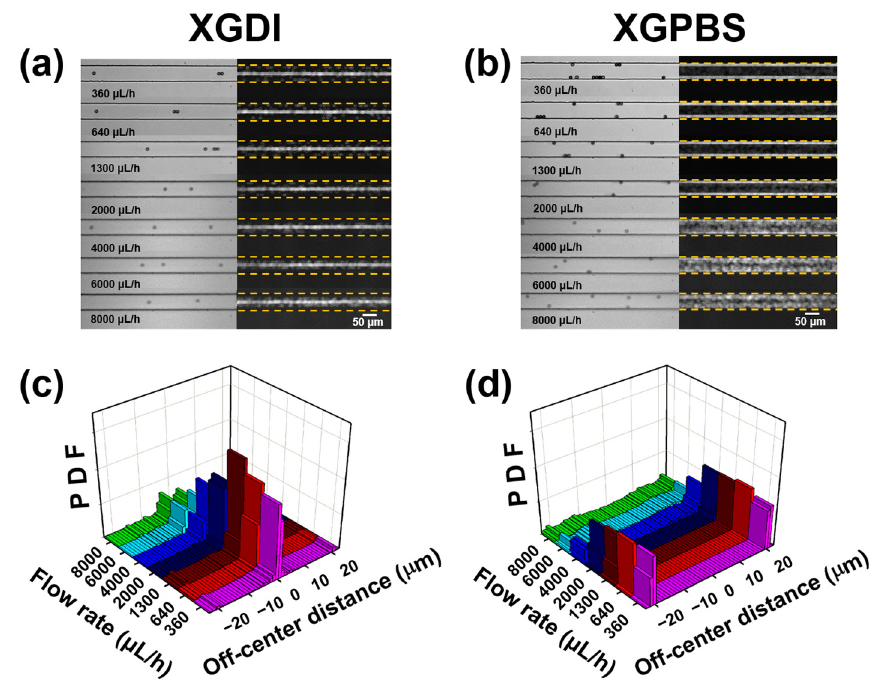
Figure 4. ( a ) Particle distributions in xanthan gum (XG) solution in deionized water (XGDI): snapshot images (left column) and standard deviation images (right column). ( b ) Particle distributions in XG solution in phosphate bu ff ered saline (PBS) solution (XGPBS): snapshot images (left column) and standard deviation images (right column). ( c ) Particle distribution function (PDF) in XGDI. ( d ) PDF in XGPBS. The images were captured 4 cm downstream from the channel inlet. The standard deviation images were obtained by stacking 2000 successive time-lapse images with the standard deviation option using ImageJ software. The particle images were slightly blurred at high flow rates ( Q ≥ 4000 µ L / h), but there was no significant problem in determining the particle